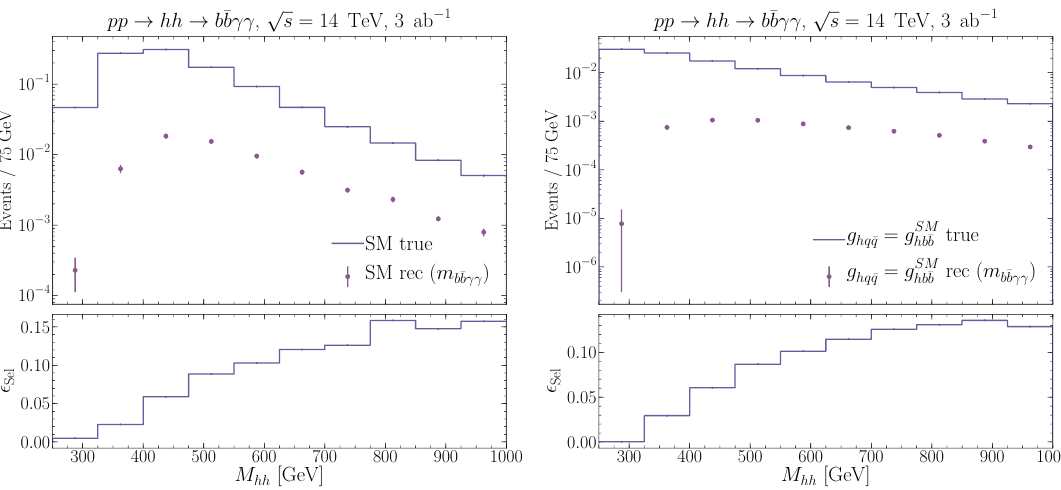
Figure 12 . Truth-level (no cuts) vs reconstructed M hh distributions for the SM (left) and the benchmark point (right). In the lower part of the plot we show the ratio between truth-level and reconstructed distribution, which is equivalent to the